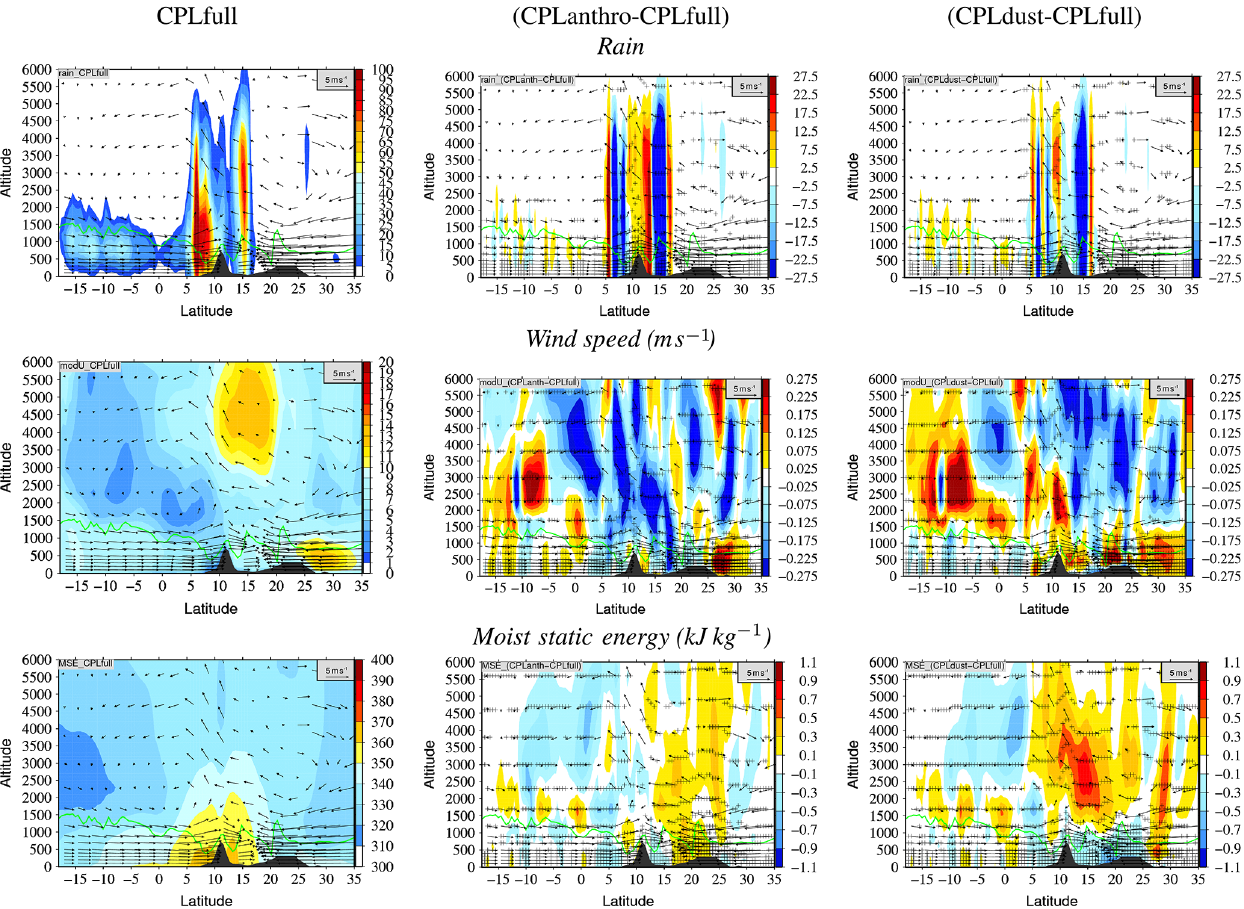
Figure 10. Vertical cross section of rain and wind speed vertical profiles, averaged from 1 to 31 July 2016 and for longitude − 10 ◦ . The mean value for CPLfull and the differences (CPLanthro–CPLfull) and (CPLdust–CPLfull) are presented. Crosses indicate locations where the differences are significant.